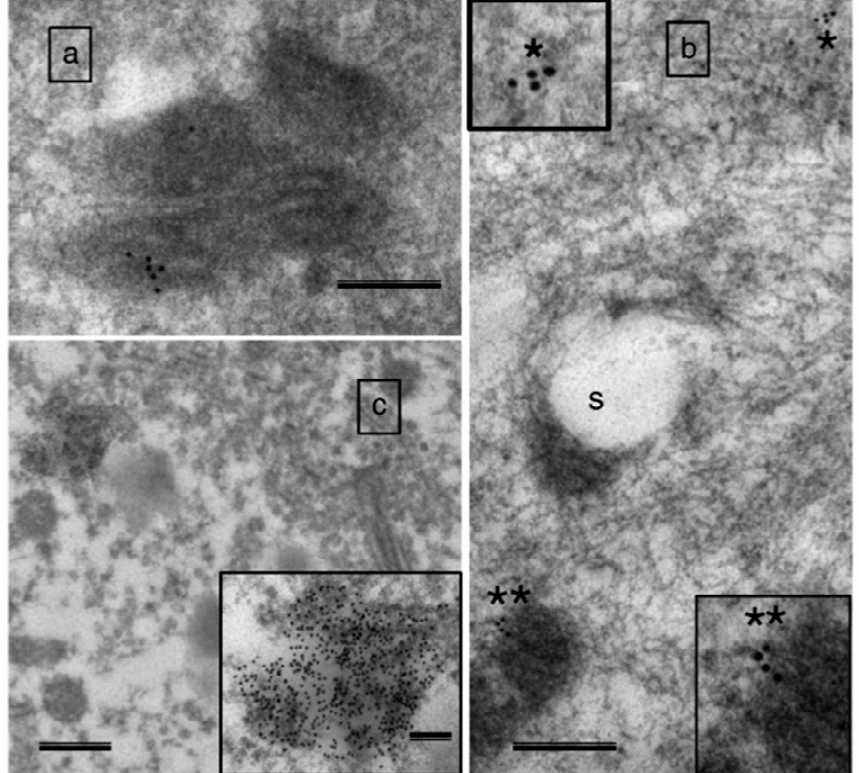
Figure 5. Some mitochondria in motoneuron terminals have released cytochrome c, associated with a corresponding activation of caspase 3. Panel ( a ) shows immunogold-labeled cytochrome c (black dots) located within the mitochondria in motoneuron terminals of a young rat, whereas in in old rat panel ( b ) cytochrome c is found in the cytoplasm (*) and there is evidence of cytochrome c being released from a mitochondrion (**). Panel ( c ) shows immunogold-labeled caspase 3 in the axonal cytoplasm. Figure reproduced from [47] with permission.